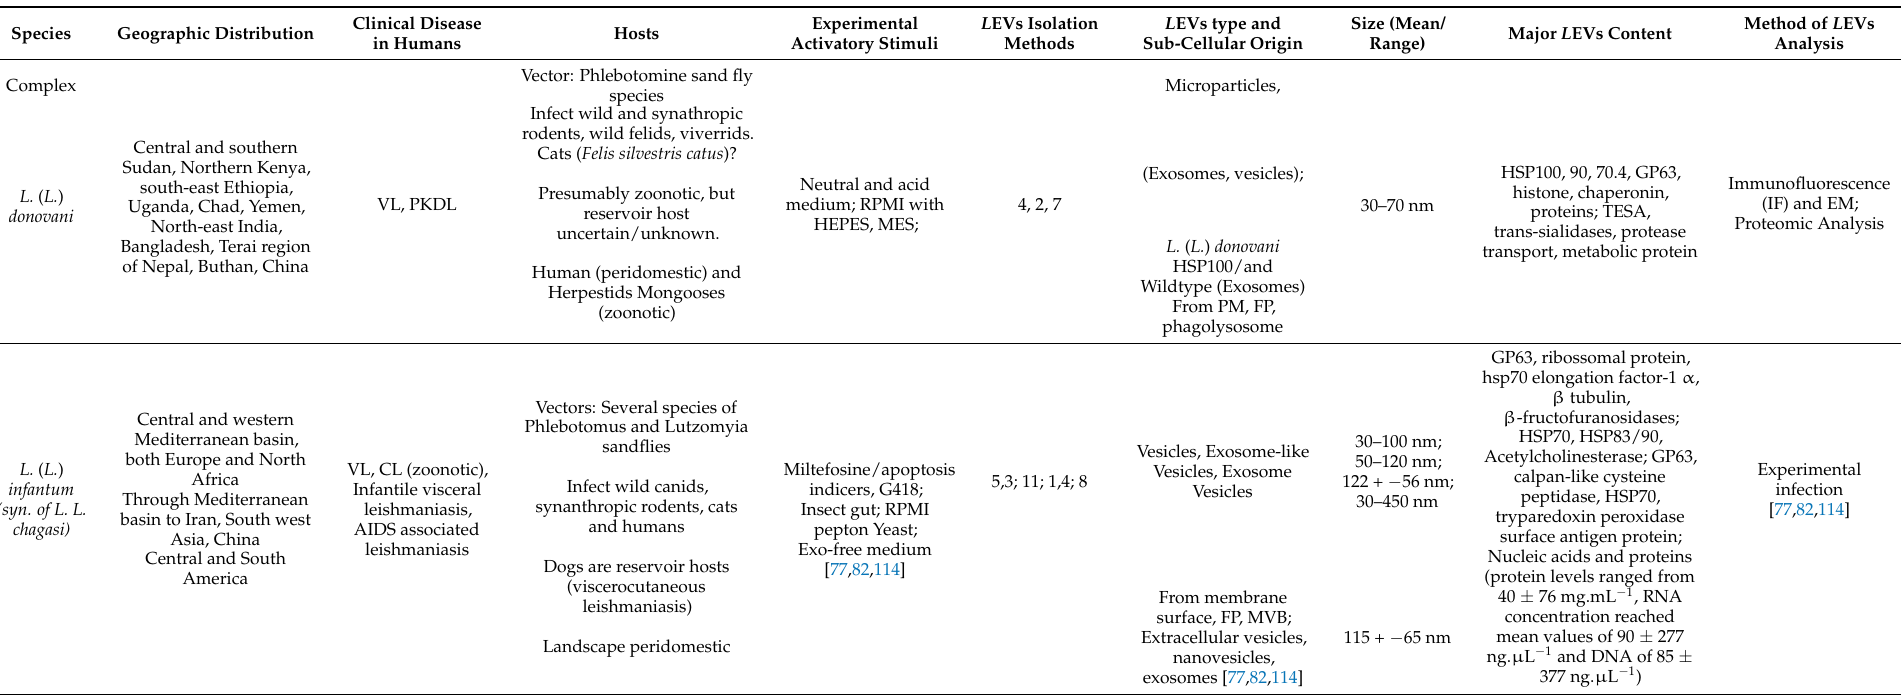
Table 1. Old and New World Leishmania species considered a potential source of animal and human infection, their main characteristics and what was published about their extracellular vesicles [8,20,24,26,27,121]. *** No additional information available.